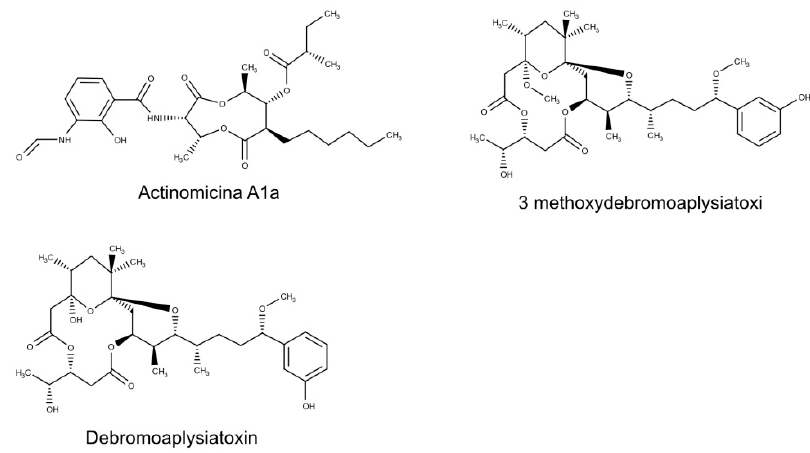
Figure 1. Structures of compounds isolated from marine bacteria with antiviral activity.